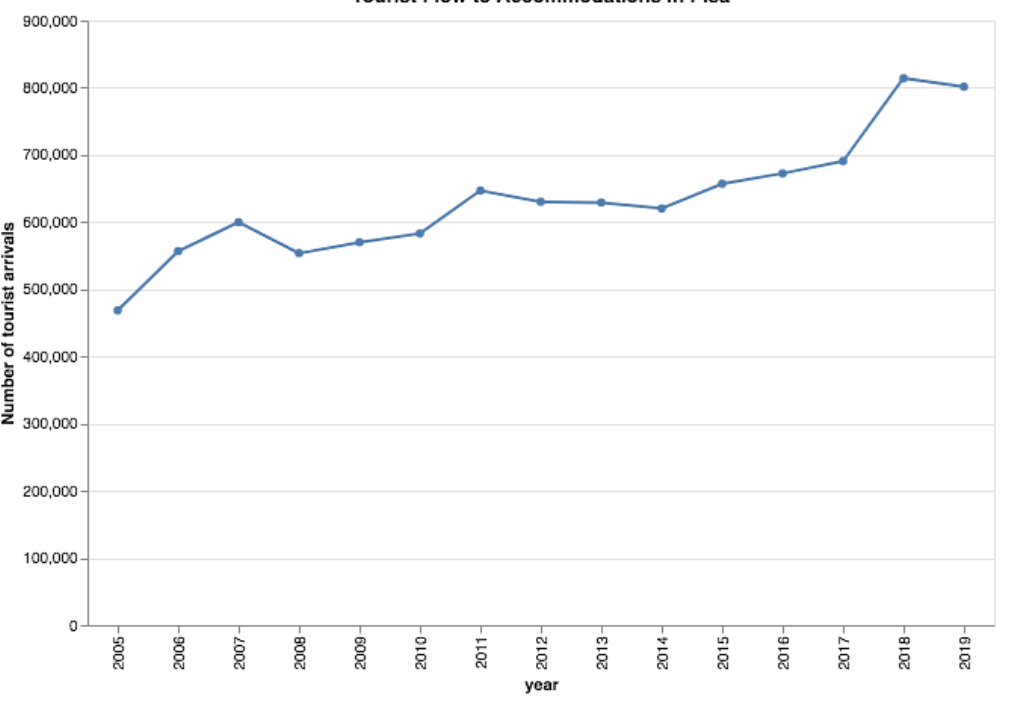
Figure 2. Number of tourists per year relative to the city of